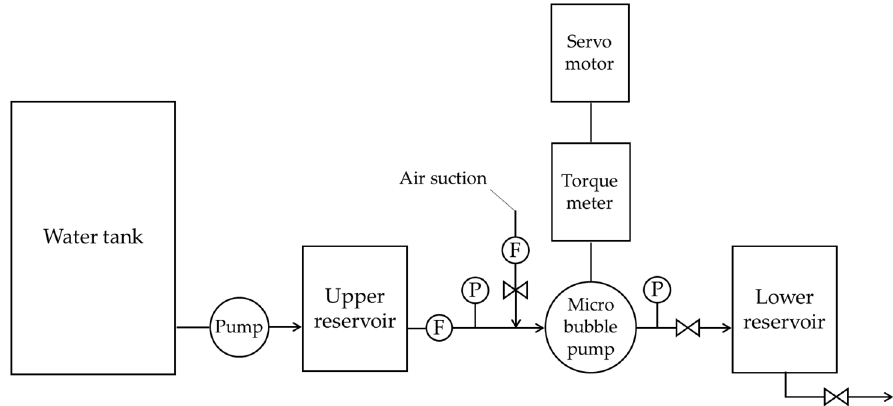
Figure 2. Schematic diagram of a microbubble pump experimental apparatus. (F: electronic flow meter, P: electronic pressure sensor).